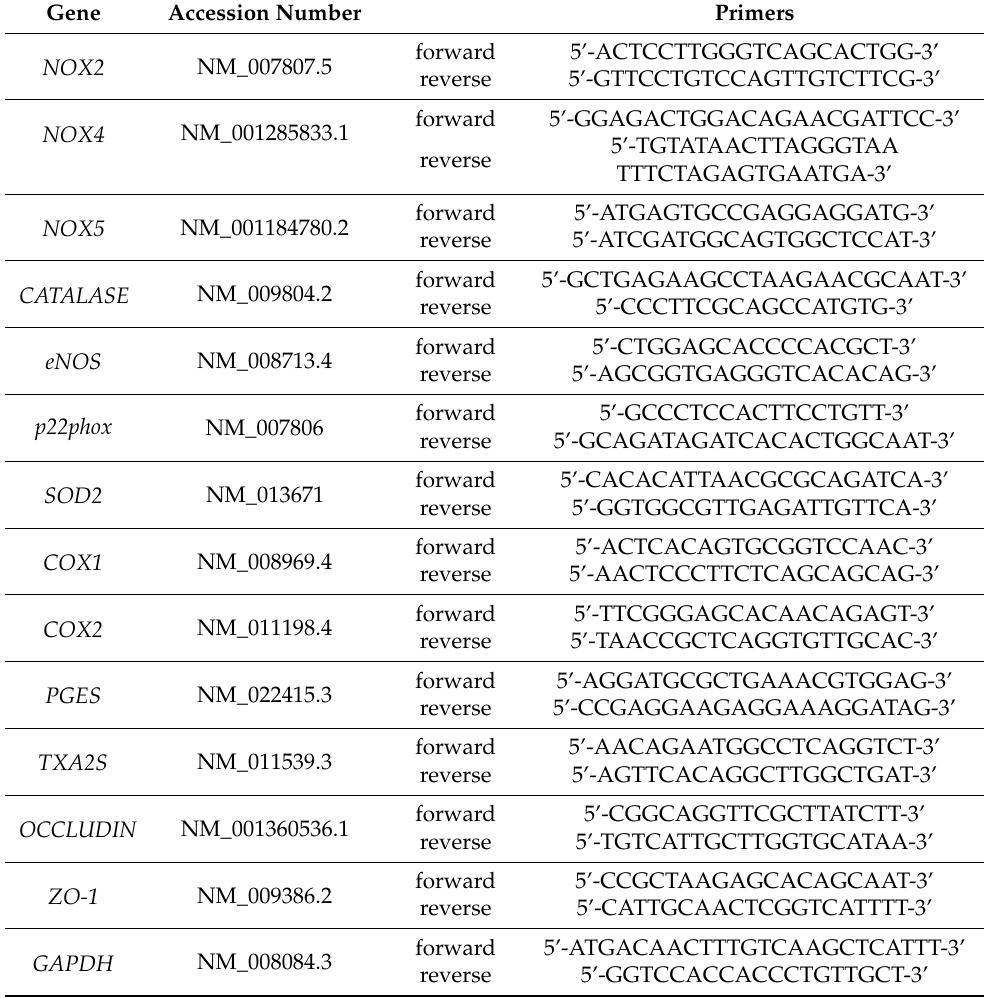
Table 1. The primers used for cDNA